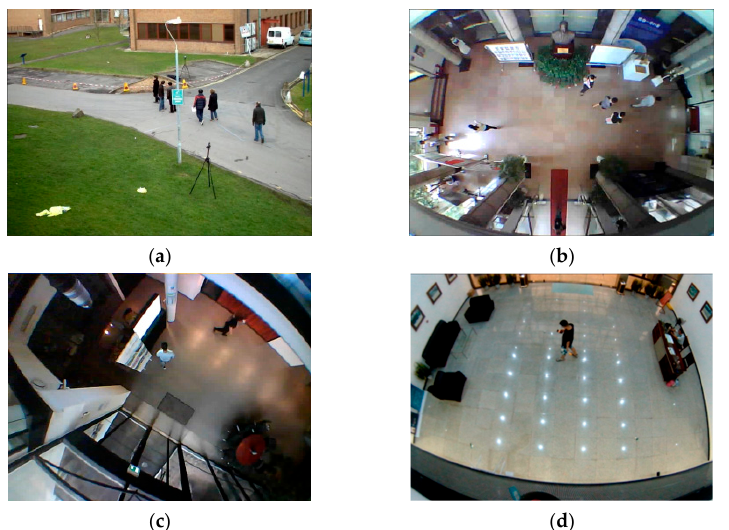
Figure 12. Database: ( a ) MOT15; ( b ) laboratory at Wuhan University; ( c ) hall of the Finland Geodetic Survey Institute; ( d ) hall of the Sirindhorn Research Center.